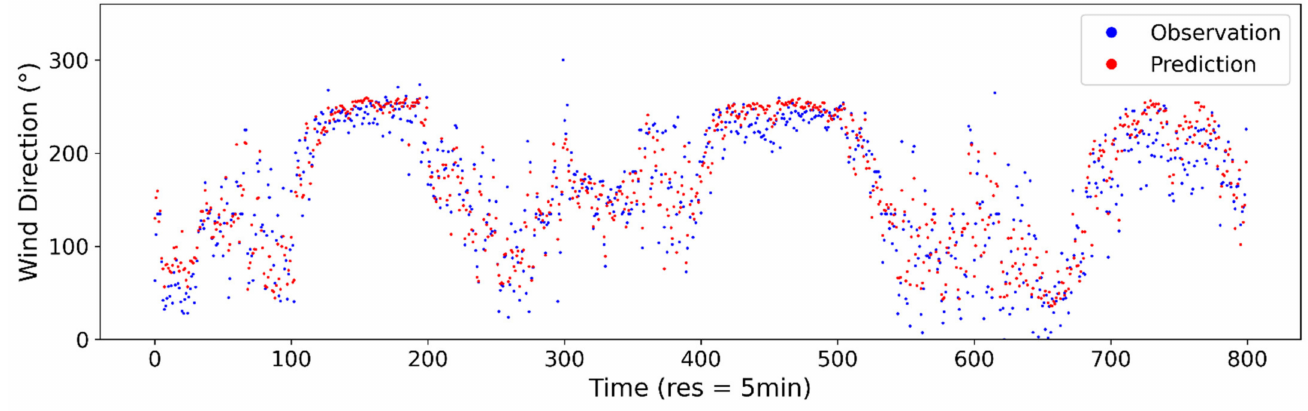
Figure A9. Estimated vs. observed wind direction at 5-min sampling interval using ANN model.